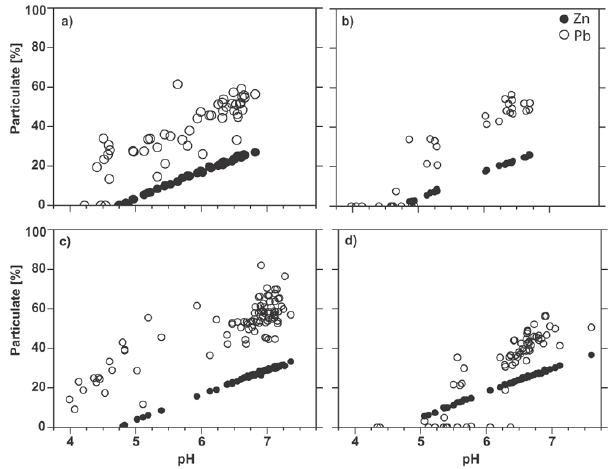
Fig. 9. Particulate fraction of Pb and Zn based on equations by Ejhed et al. (2012), estimating the fraction (%) that would not pass a 0.45µm filter at the four rivers (a) Danshytte ˚ an, (b) Getryggs ˚ an, (c) Anr˚ase ˚a and (d) Lugn˚an. The equations were based on a large data set of samples ( n = 800) from Swedish watercourses and lakes that were sampled for both total and filtered metals. As those empirical equations were mainly driven by pH and water colour, we chose to plot the calculated fraction as a function of pH for each